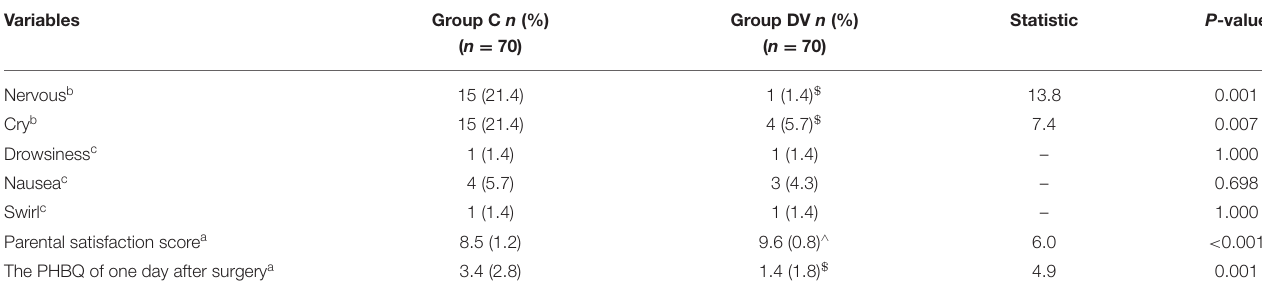
TABLE 3 | Side-effects and the parental satisfaction score and the PHBQ